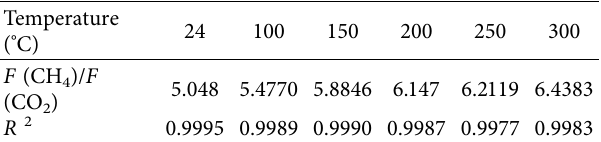
Table 4: The fitting parameters for equation (1) at different temperatures.